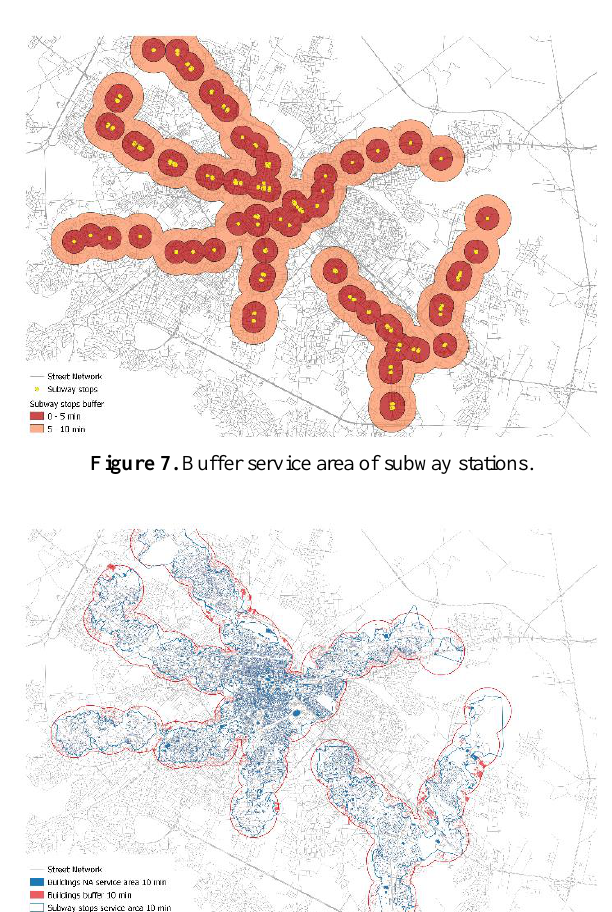
Figure 6. Network Analysis service area of subway stations.